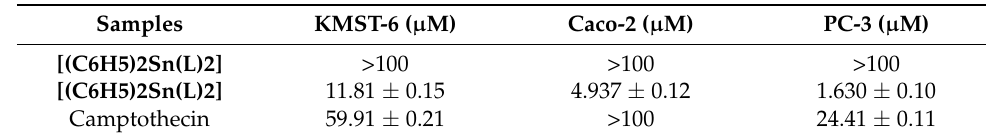
Table 3. The IC 50 of the mono- and diphenyltin(IV) N -methyl- N -hydroxyethyldithiocarbamate complexes and camptothecin.